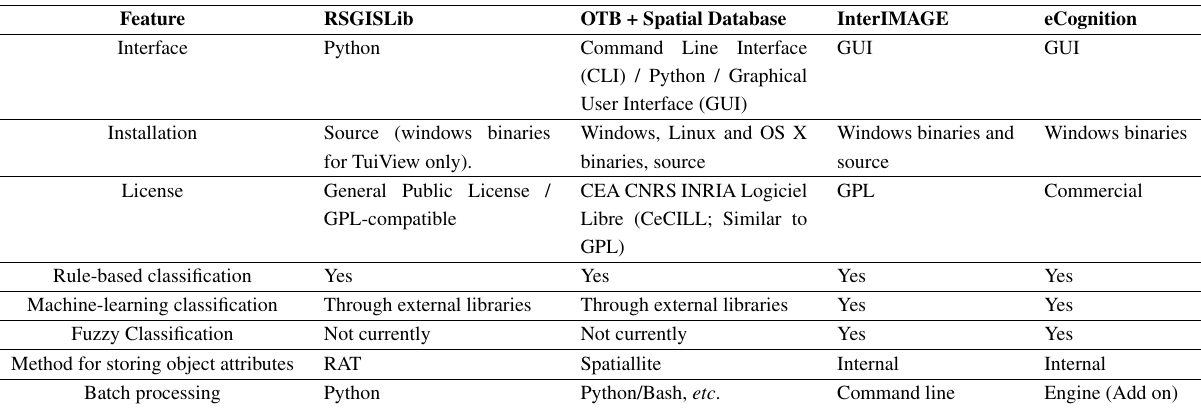
Table 2. A comparison of features for different Geographic Object-Based Image Analysis (GEOBIA) packages. OTB, Orfeo